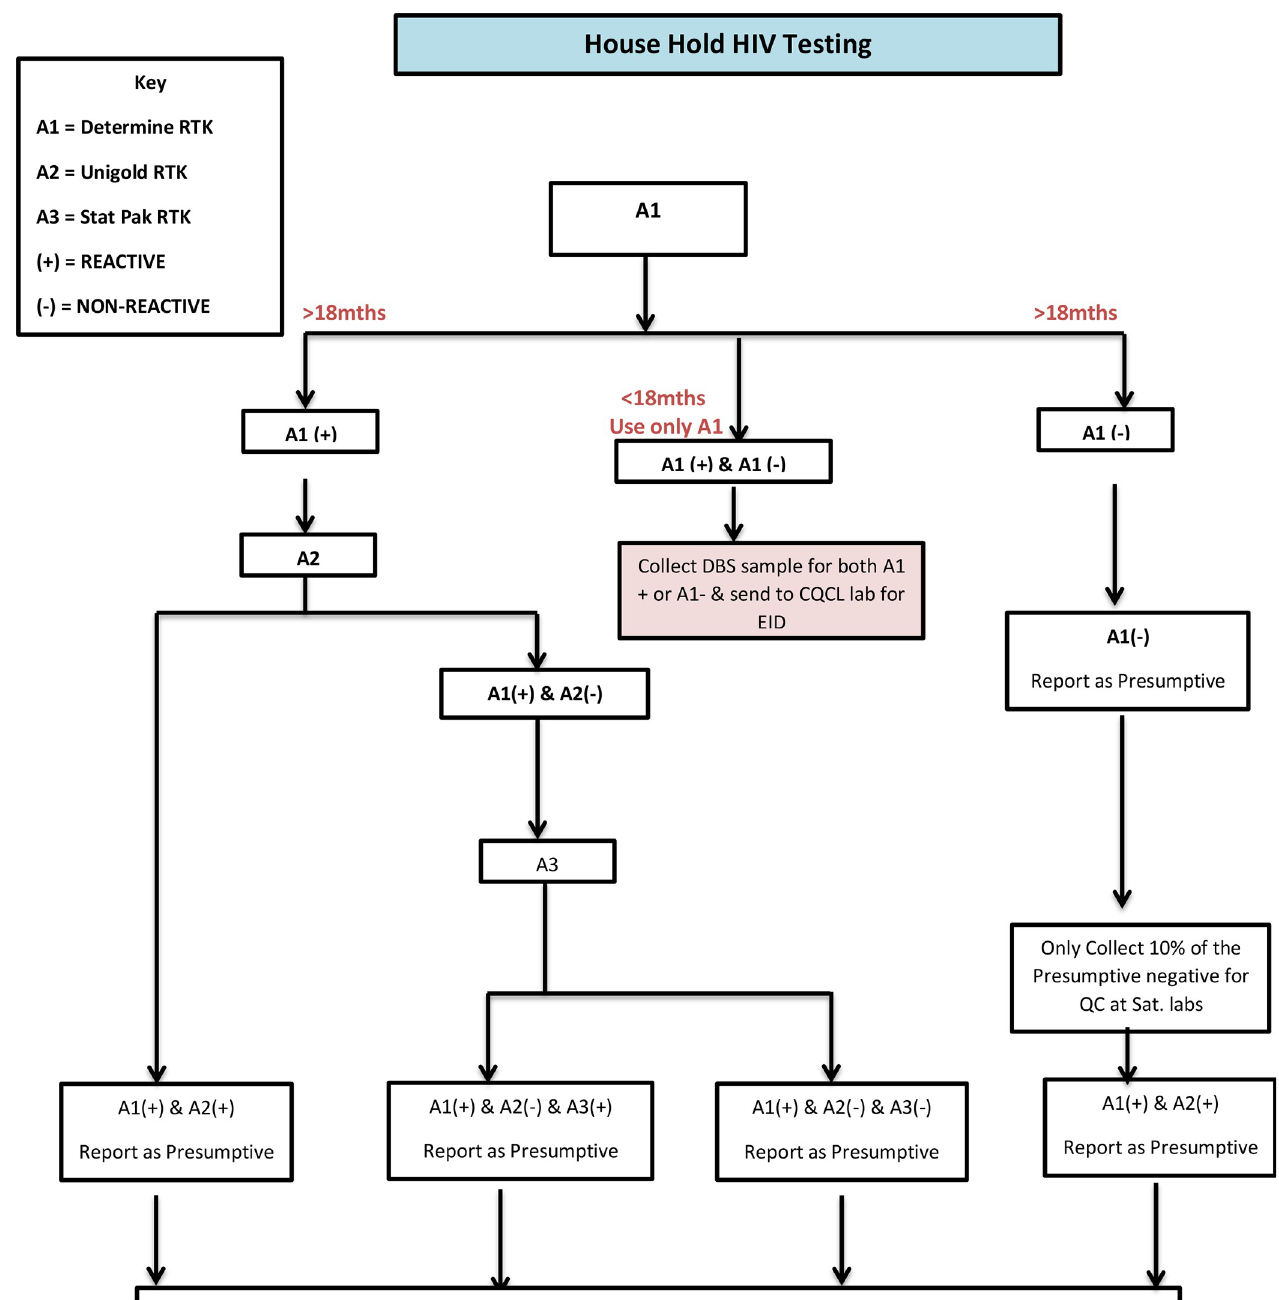
Fig 1. Household HIV testing algorithm, AKAIS